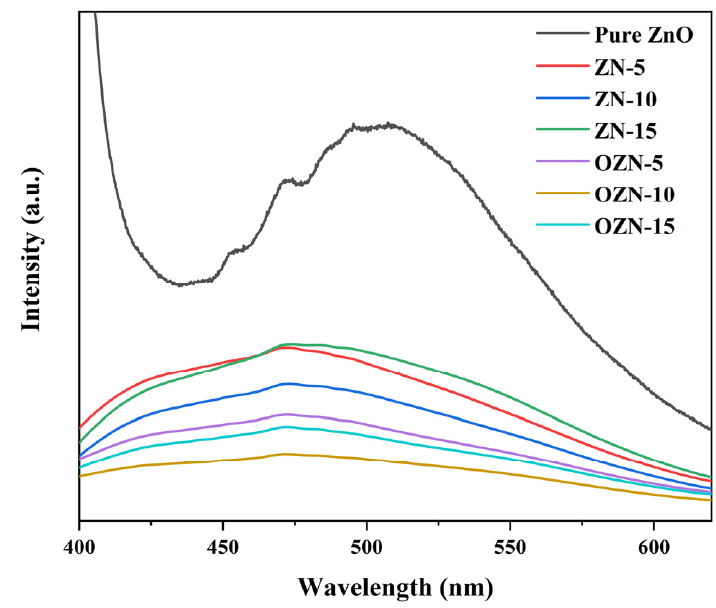
Figure 8. PL spectra of ZnO, ZN and OZN nanoparticles.